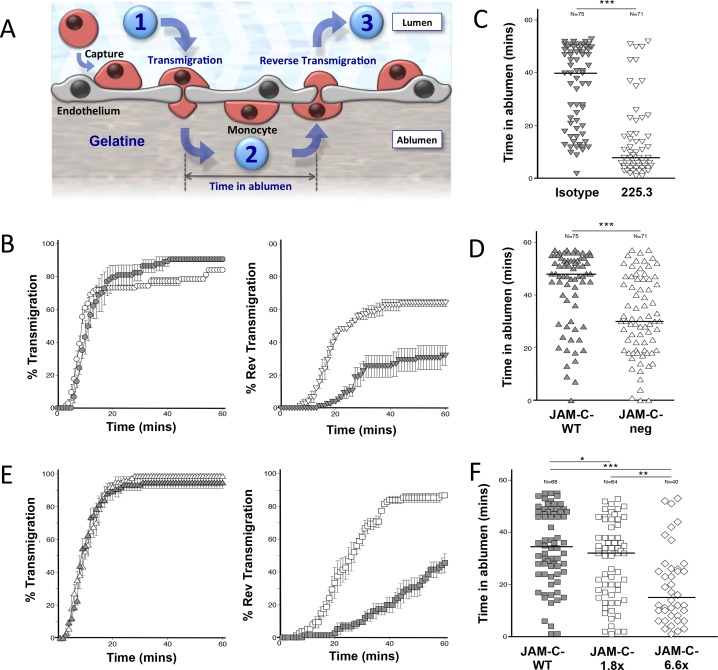
Trafficking profiles of monocytes on activated HUVECs in a flow assay system.Scheme of monocyte adhesion, TEM and rTEM. (A) Monocytes captured from flow adhere to HUVEC luminal surfaces before transmigrating into the abluminal compartment (Step-1). The period of time occupied by the monocyte can be measured (Step-2) before the monocyte undergoes rTEM (Step-3). Blockade of JAM-C or increased vascular JAM-C expression induced higher levels of rTEM. (B) Blocking JAM-C 225.3 (white circles) had no effect on primary-TEM compared to conditions using an isotype control (grey circles). Blocking JAM-C 225.3 (white inverted triangles) led to increased rTEM of abluminal monocytes compared to isotype controls (grey inverted triangles). Data are presented as the mean of three fields ±SEM. Data shown is representative of three independent experiments.(N = 3). Decreased vascular JAM-C expression leads to a reduced occupation time of transmigrated monocytes. (C) Transmigrated monocytes on HUVECs with down-regulated JAM-C by siRNA transfection (JAM-C-neg) spent shorter intervals in the abluminal compartment (white triangles) compared to a sham transfection control (JAM-C-WT) (grey triangle). Data shown is representative of two independent experiments (N = 2). JAM-C blockade reduced the occupation interval of transmigrated monocyte in the abluminal compartment. (D) The time spent by individual monocyte in the abluminal compartment was assessed using 225.3 (white inverted triangles). This was shorter than co-cultures treated with an isotype control (grey inverted triangles). Data shown is representative of two independent experiments (N = 2). Increasing expression of JAM-C leads to a reduced occupation time of transmigrated monocytes. (E) HUVECS expressing JAM-C-1.8x (white triangles) had no effect on primary-TEM compared to EGFP-control transfected HUVECs (grey triangles). HUVECS expressing JAM-C-1.8x (white squares) led to increased rTEM of abluminal monocytes compared to the controls (grey squares). Data are presented as the mean of three fields ±SEM. Data shown is representative of three independent experiments (N = 3). Increasing expression of JAM-C also reduced the occupation interval of transmigrated monocyte in the abluminal compartment. (F) The time spent by individual monocytes in the abluminal compartment showed a reduction with increased expression of JAM-C-1.8x (white squares) and JAM-C-6.6x (white diamonds) compared to controls (grey squares). JAM-C-1.8x and JAM-C-6.6x had 1.8- and 6.6-times more expression than control JAM-C-WT respectively. Median values are marked. Mann–Whitney test was used for all dot plots statistical analyses. Data shown is representative of two independent experiments (N = 2).